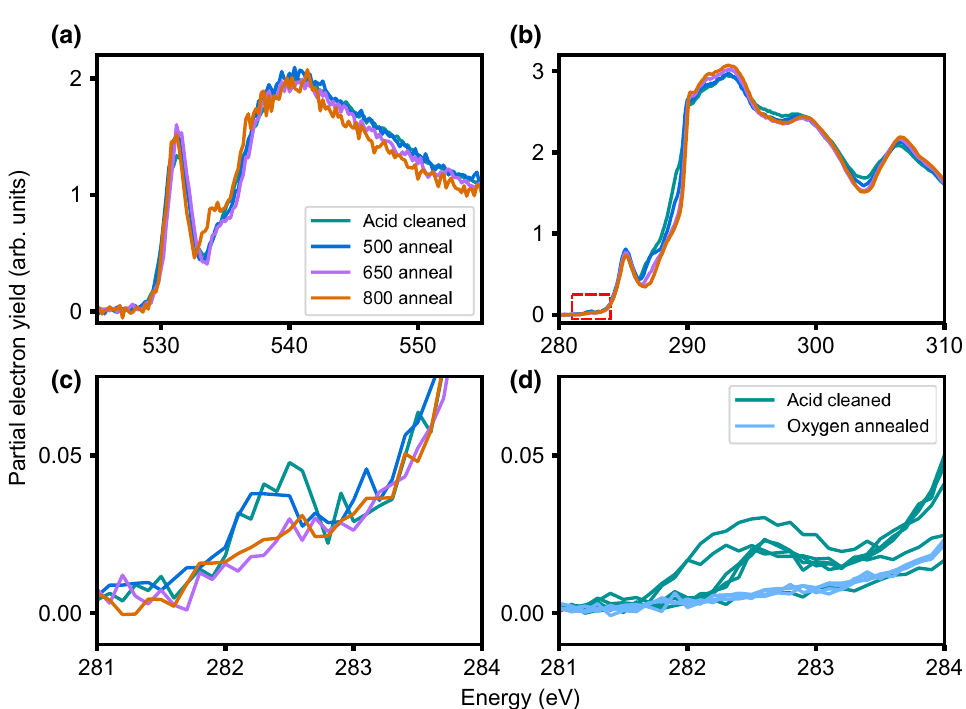
FIG. 5. NEXAFS through annealing. (a) Oxygen edge NEXAFS for a diamond sample with initial acid cleaned surface (green), after 500 ◦ C annealing (blue), 650 ◦ C annealing (purple), and 800 ◦ C annealing (orange). (b) Carbon edge NEXAFS of the same annealing sequence on the same sample. Red box indicates the location of the dangling bond peak, shown in detail in (c). (c) Detailed view of the dangling bond peak showing removal at higher annealing temperatures. (d) Detailed view of the dangling bond peak for several samples with initially prepared acid cleaned surfaces (green) and oxygen annealed surfaces (blue), showing an absence of the peak for oxygen annealed surfaces. Oxygen annealing procedure and suppression of the DEER signal are described in Ref.